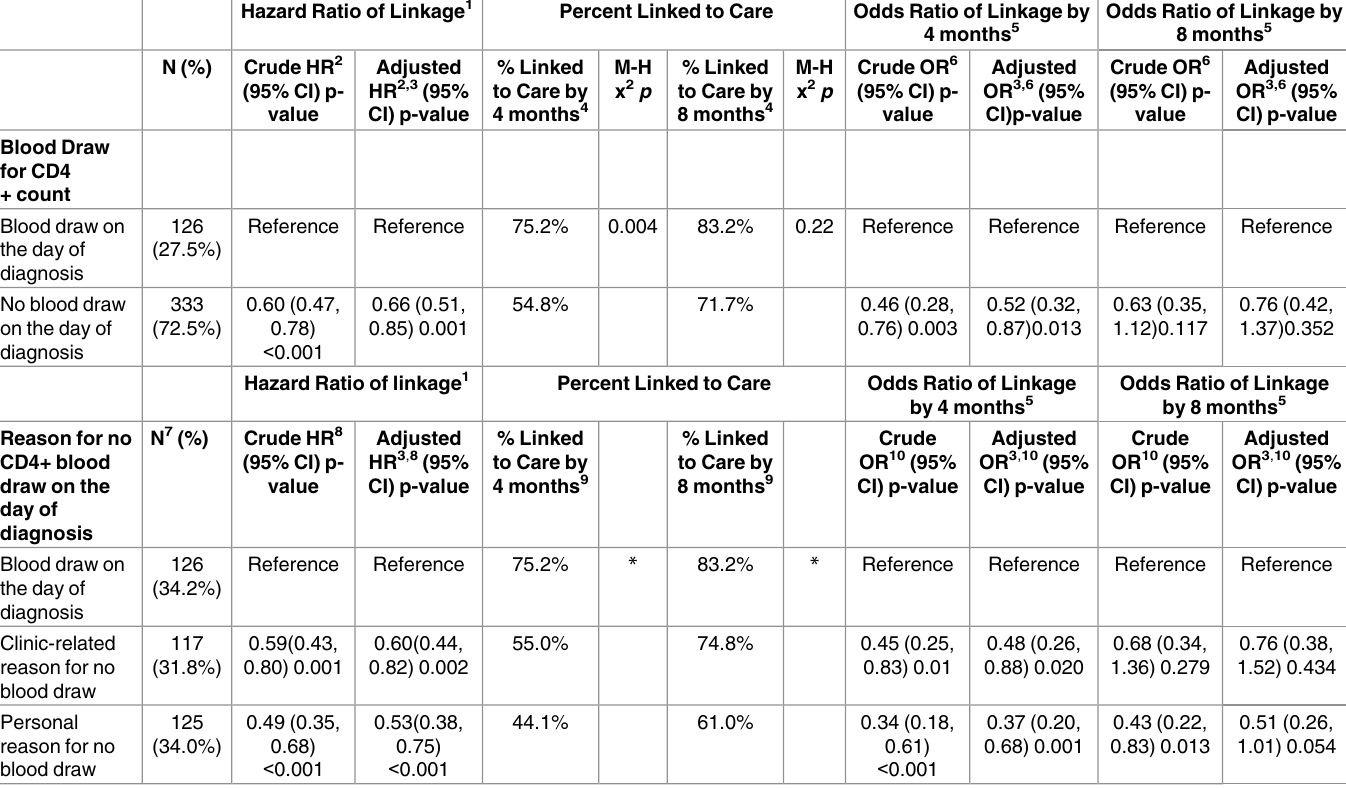
Table 3. Linkage to care by day-of-diagnosis blood draw for CD4+ count and reasons for no day-of-diagnosis blood draw, newly-diagnosed HIV + women and men, Durban, South Africa,